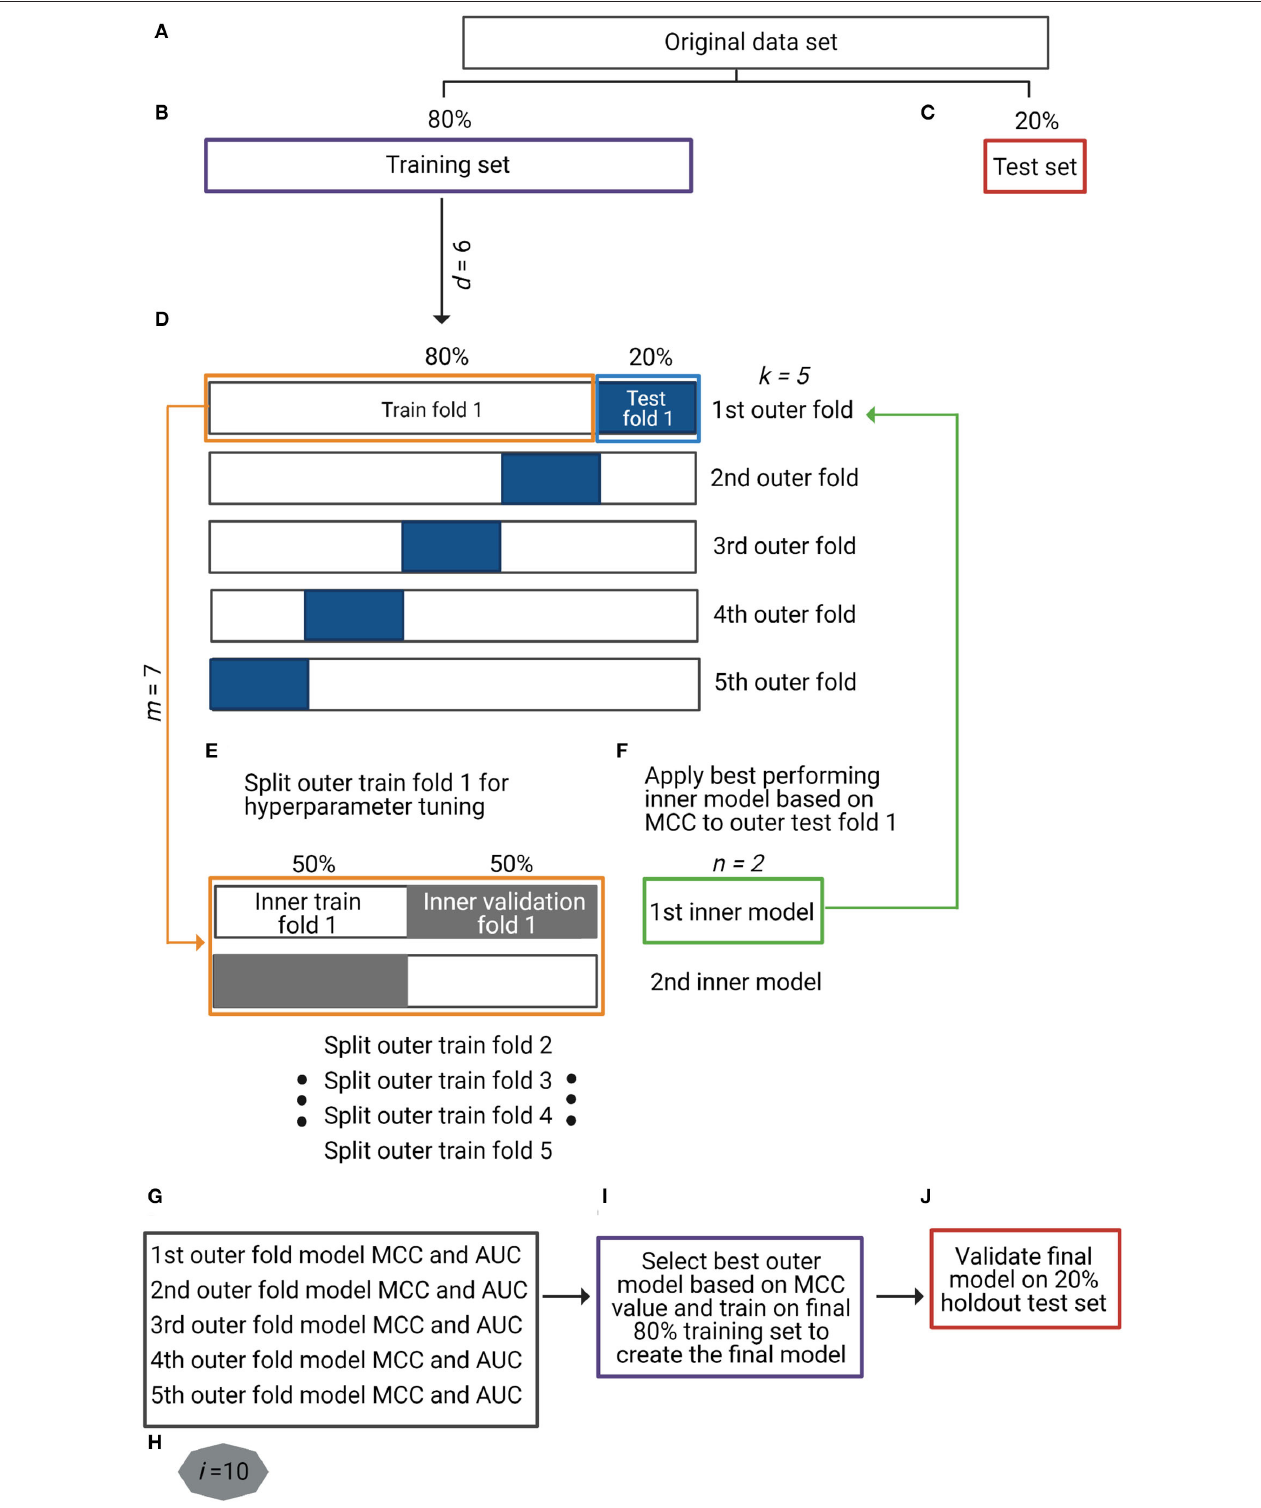
FIGURE 1 | Overview of the study’s analytical strategy. (A–C) The original dataset was split into a training set (80%) (purple box in B ) and a holdout test set (20%) (red box in C ) by maintaining the original ratio between classes in the partitions. Data augmentation techniques were applied to the training set, making a total of six different input data types ( d = 6), including baseline non-augmented and differently augmented data types. (D) For the nested cross-validation (nCV) approach, the